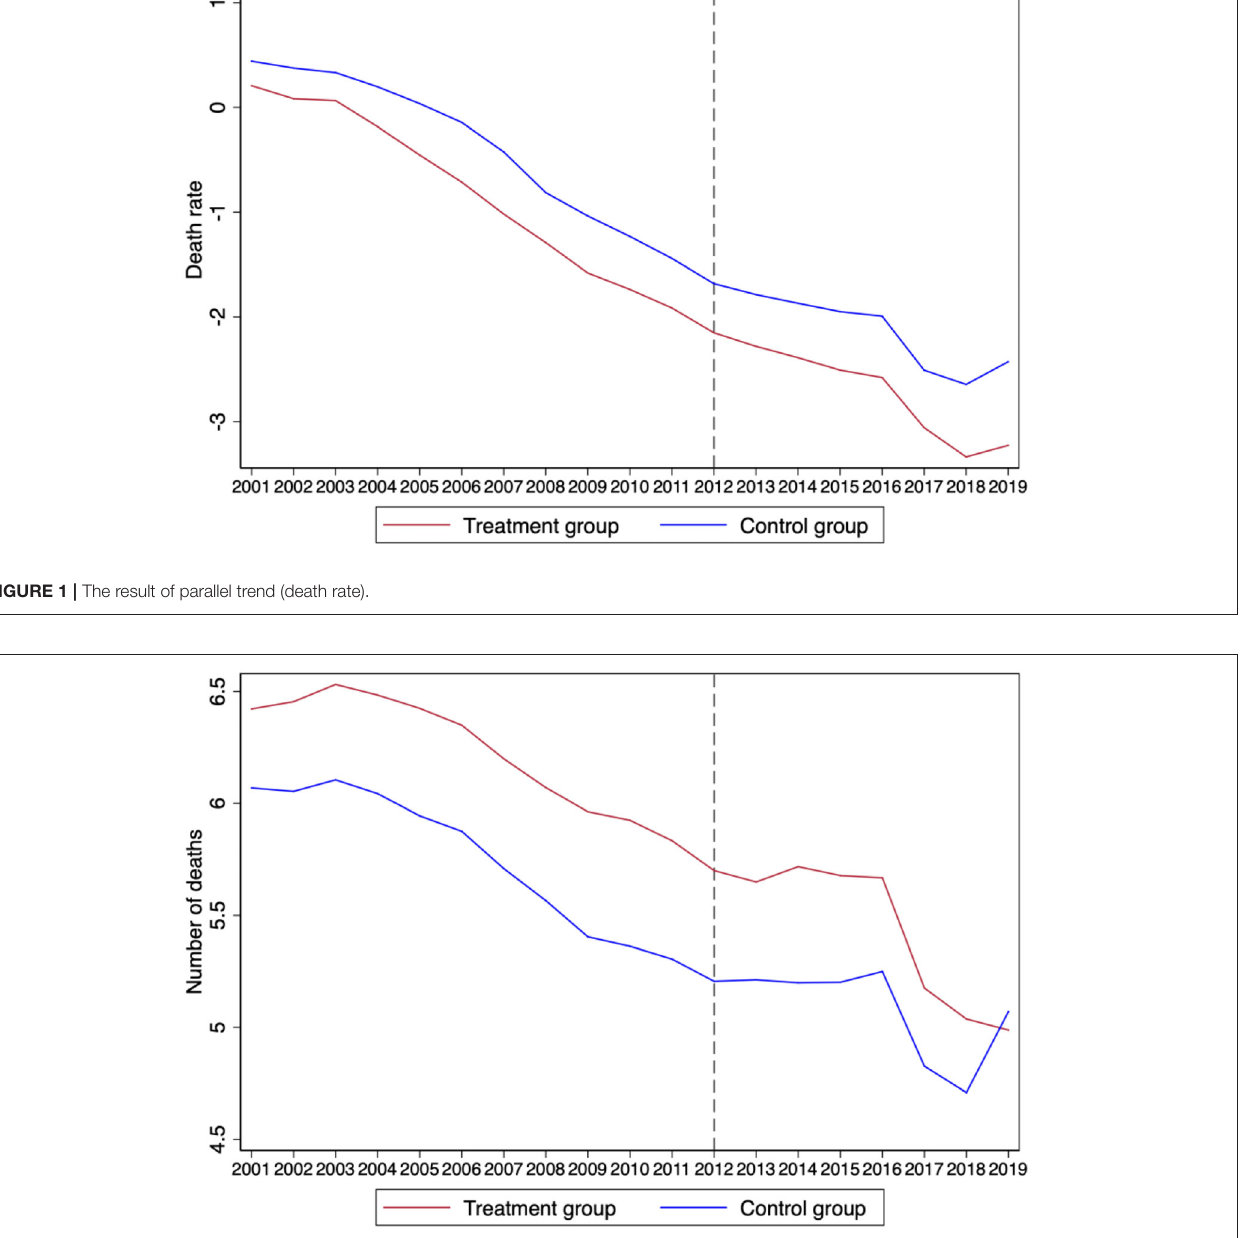
FIGURE 2 | The result of parallel trend (number of